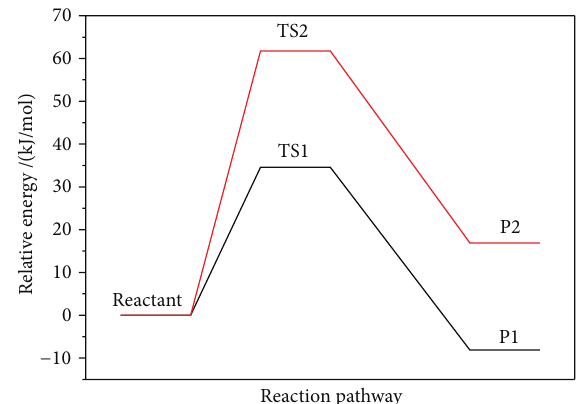
Figure 3: Potential energy surfaces of two different dimerization processes of alkyl